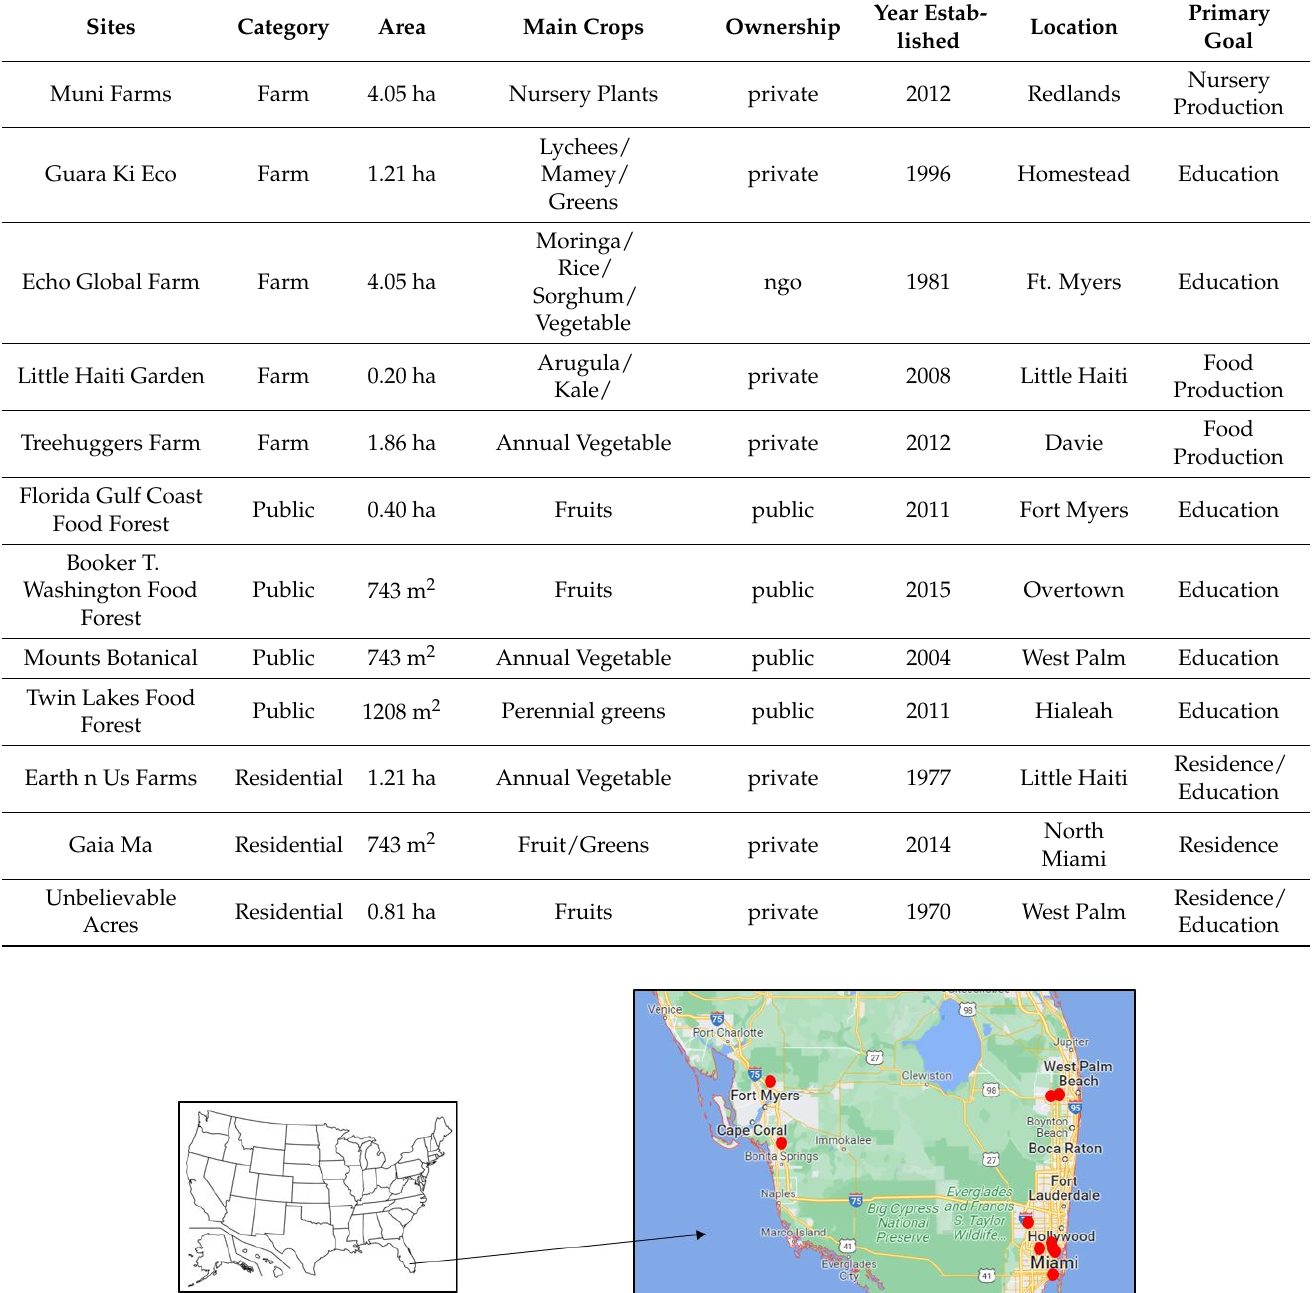
Table 1. Descriptive characteristics of the sample study sites.